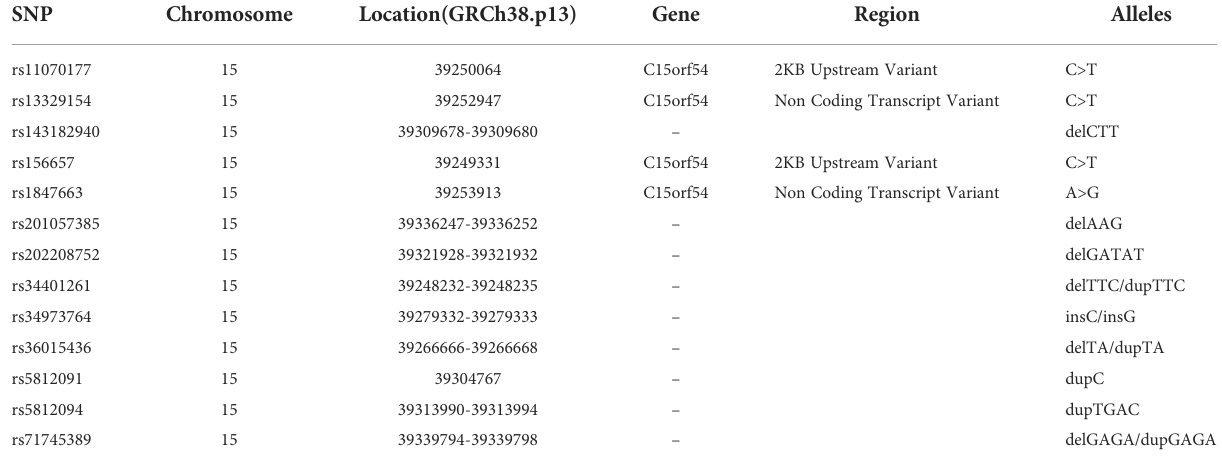
TABLE 1 Detailed information about